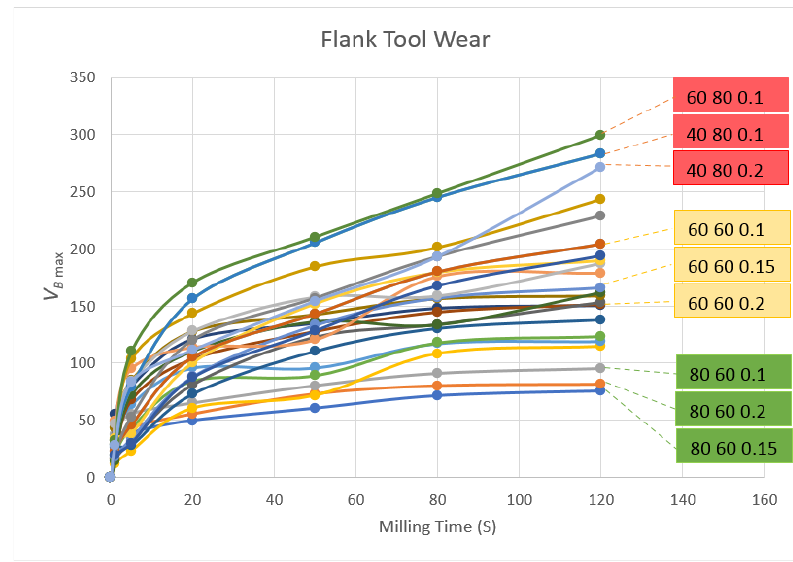
Figure 9. Tool wear curves for different cutting conditions.